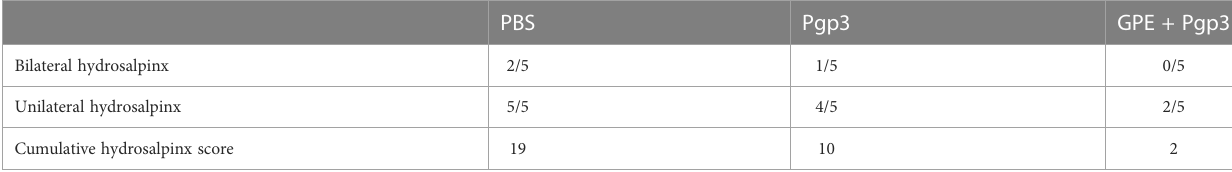
TABLE 3 Hydrosalpinx rate and cumulative score of infected